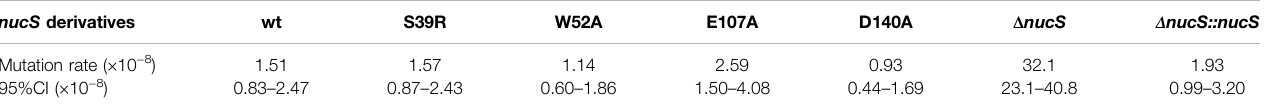
TABLE1| Mutationratesof M.smegmatis andits nucS mutantallelederivatives.Ratesofspontaneousmutationsconferringrifampicinresistancein M.smegmatis mc 2 155 (WT) and wild-type host expressing a mutant allele of nucS . nucS